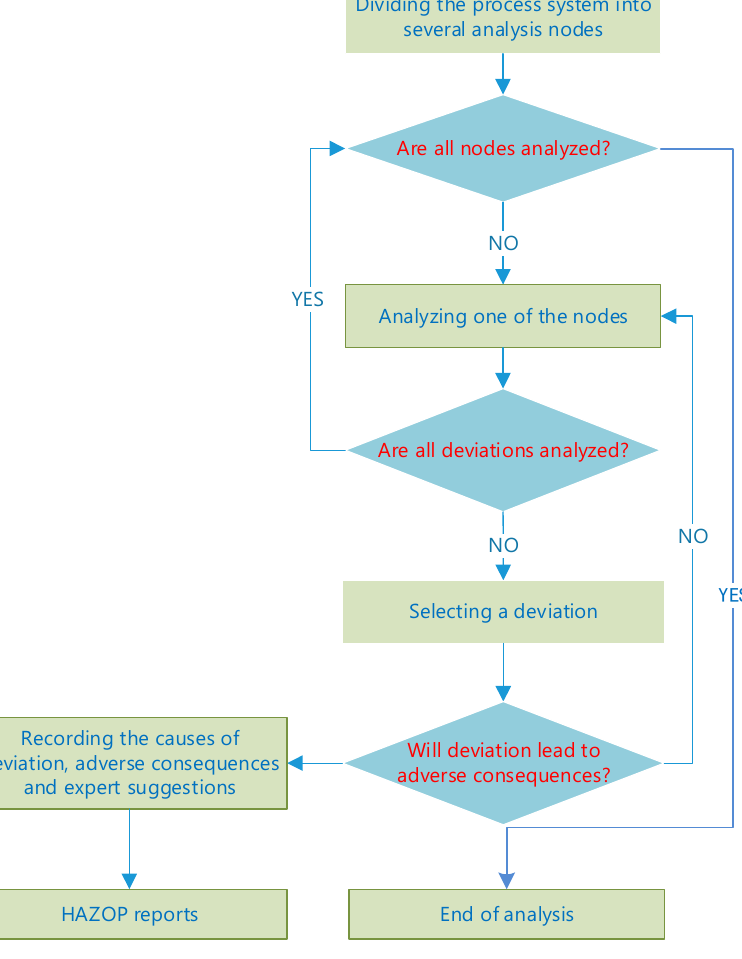
Figure 1. The analysis process of HAZOP.